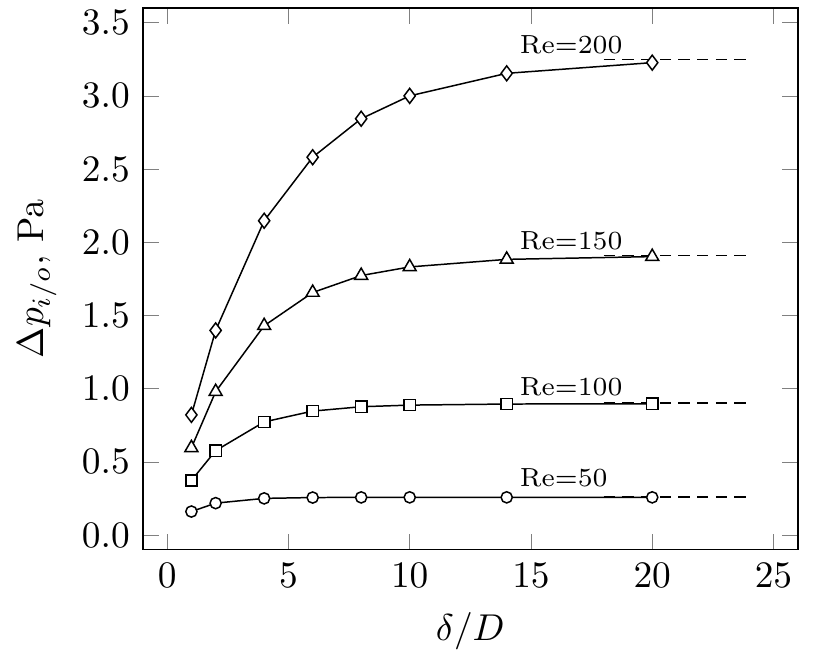
Figure 5. Pressure drop in the spacing between substrates for several channel Re and spacing lengths. The dashed lines are ( ∆ p i + ∆ p o ) from Equations (9) and